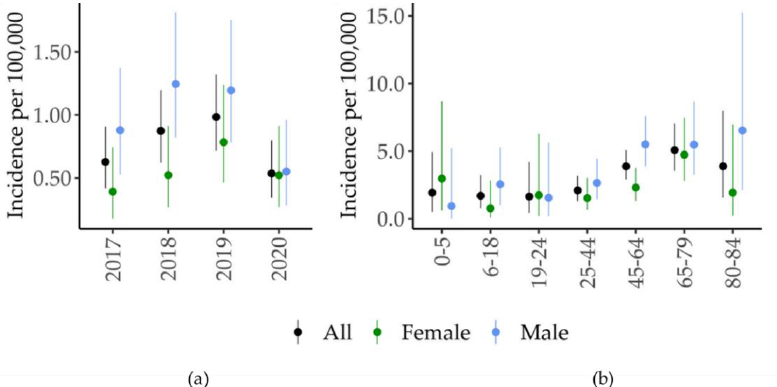
Figure 3. Incidence of tegumentary leishmaniasis by sex and year ( a ) and by age ( b ), Emilia-Roma- gna region (northeastern Italy), 2017 – 2020. CL, cutaneous leishmaniasis; ML, mucosal leishmania- sis.